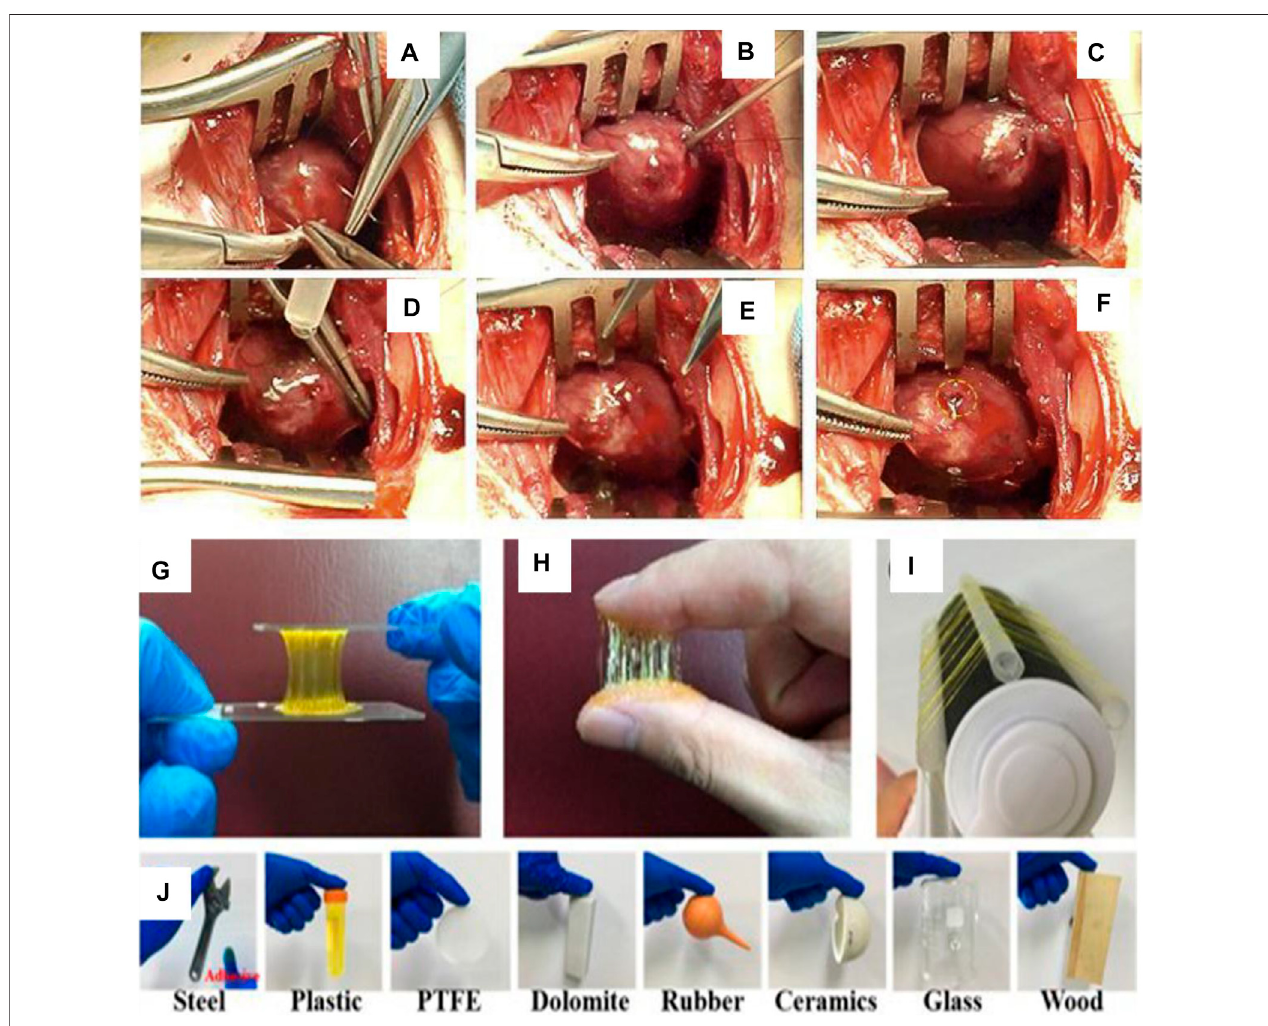
FIGURE 7 | Polyethylene glycol/lysozyme hydrogel adheres to the defect site of the left ventricular wall in rabbits. (A – F) Hydrogel participates in the process of sealing the left ventricular defect (Tan et al., 2019). II. Adhesion experiments of aldehyde-functionalized hyaluronic acid/3,3 ′ -dithiobis (propionyl hydrazide) hydrogels. (G,J) Hydrogels adhered to various substrate surfaces (Sigen et al., 2021).